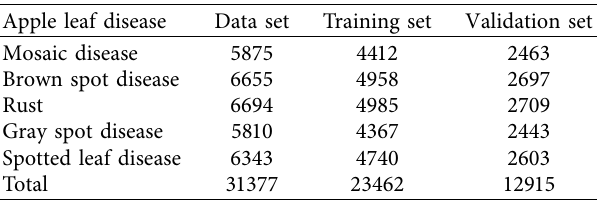
Table 1: Data distribution.